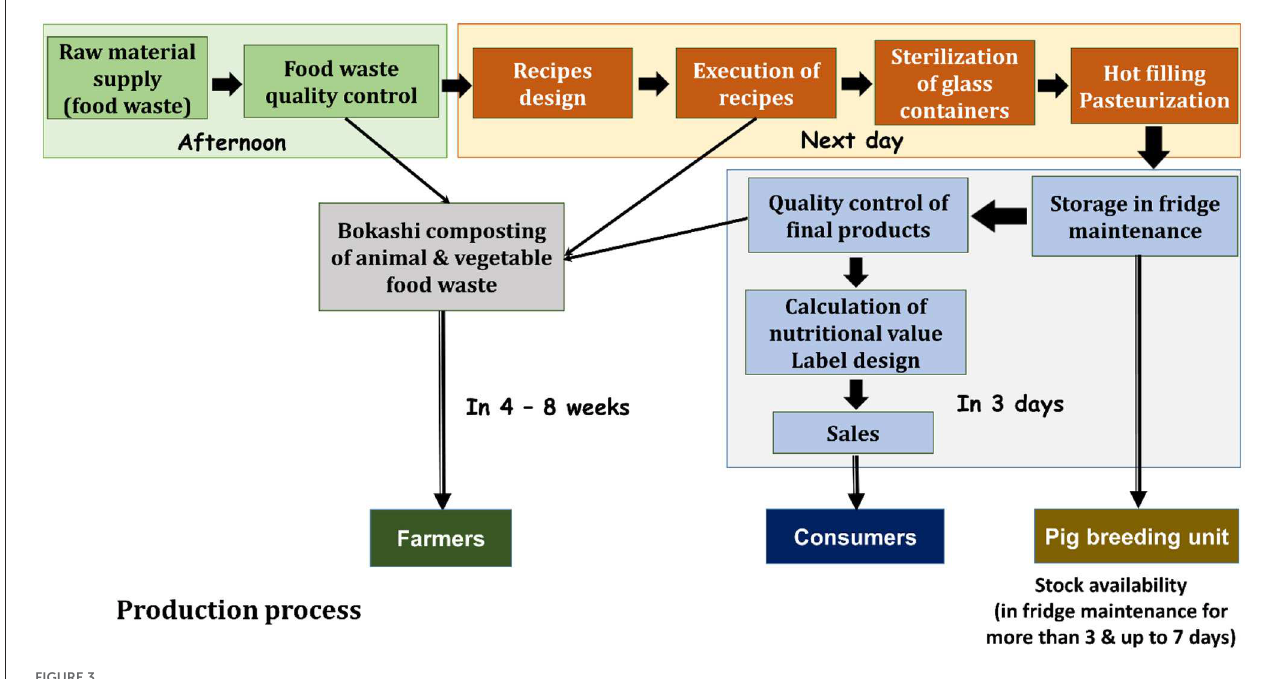
FIGURE3 The production